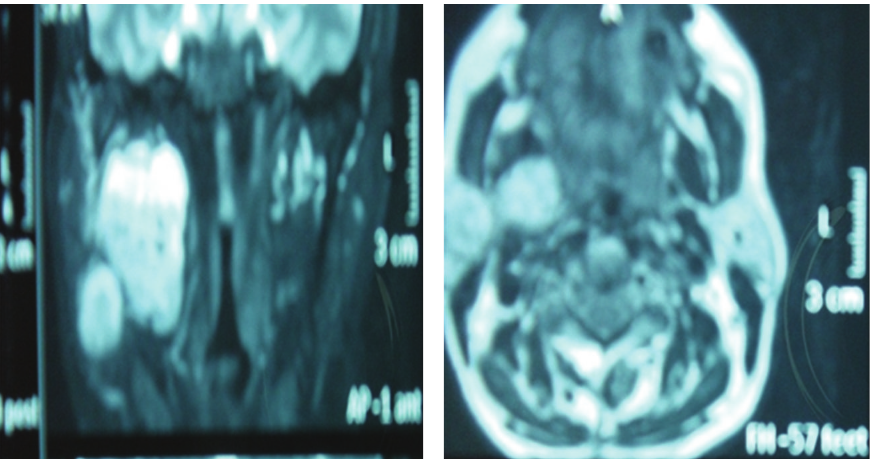
Figure 4: MR image shows the involving of the deep lobe of the right parotid gland.